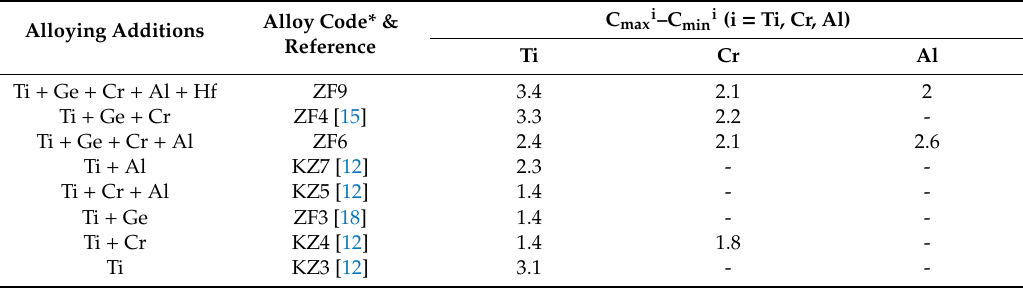
Table 7. Effect of alloying on macrosegregation of Al, Cr and Ti in as cast Nb-18Si silicide-based alloys.